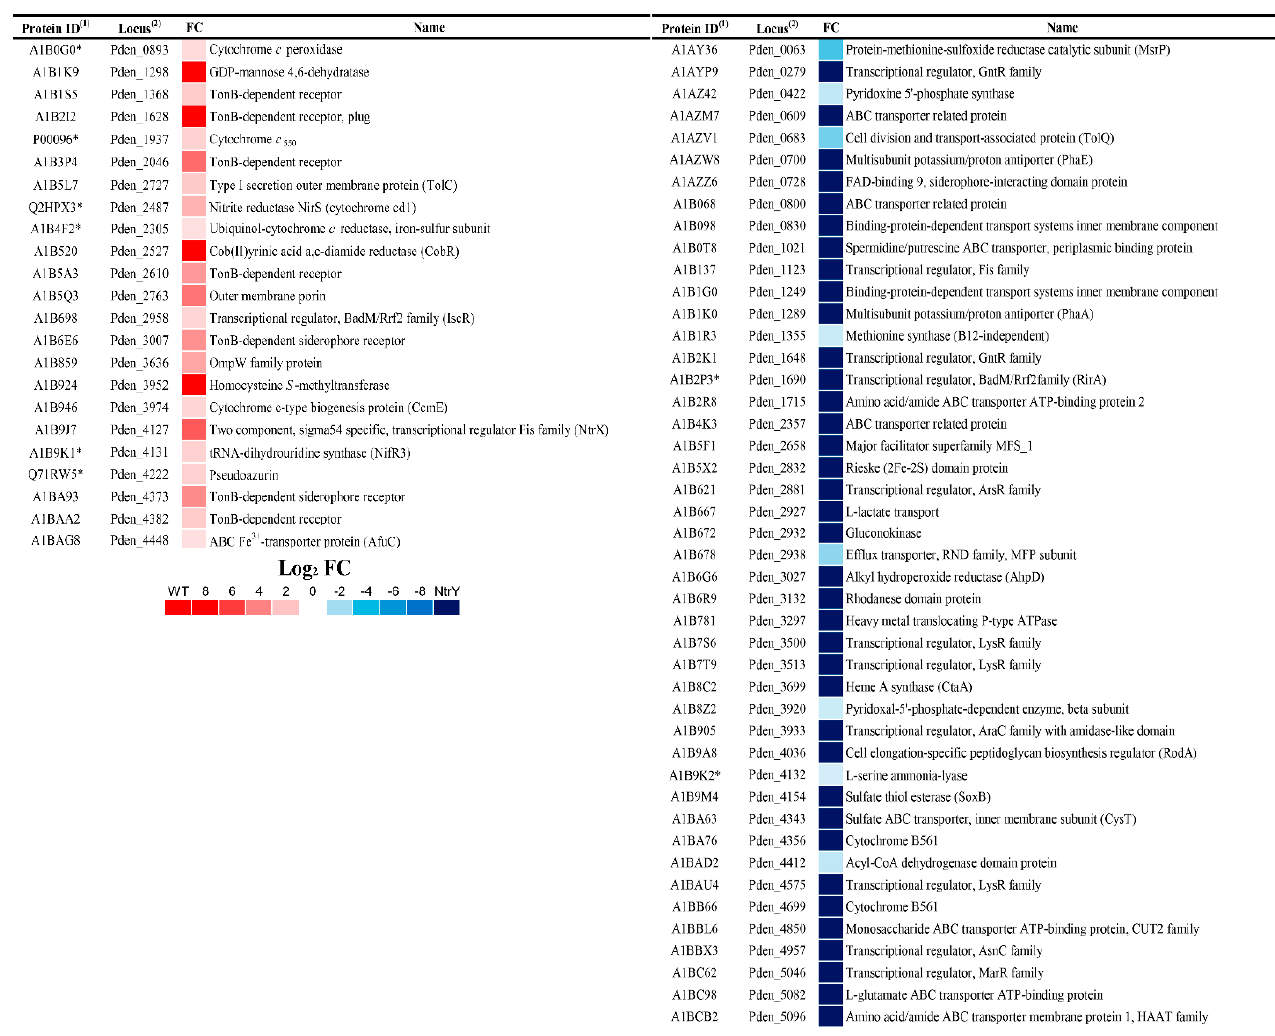
Figure 3. Heatmap of the comparative proteomic analysis of the wild-type strain versus the NtrY mutant of P. denitrificans . Differential proteomic analysis by LC–MS/MS of P. denitrificans wild-type strain and NtrY mutant was performed. Cells were grown anaerobically under denitrifying conditions, with nitrate as the sole nitrogen and energy source. Heatmap shows the fold changes (FC), represented as log 2 normalized expression using the wild-type proteome as reference. After the t -test analysis was applied, the differential expressed proteins showed a p -value ≤ 0.05 and either a fold change ≥ 2 (exclusive or over-represented in the wild-type strain) represented in red or a fold change ≤ 0.5 (exclusive or over-represented in the NtrY mutant) represented in blue. (1) Protein code according to Uniprot database under the accession number UP000000361. (2) Genes annotated from GeneBank (T00440). (*) Detected only in two or one biological samples or displayed a high p -value.